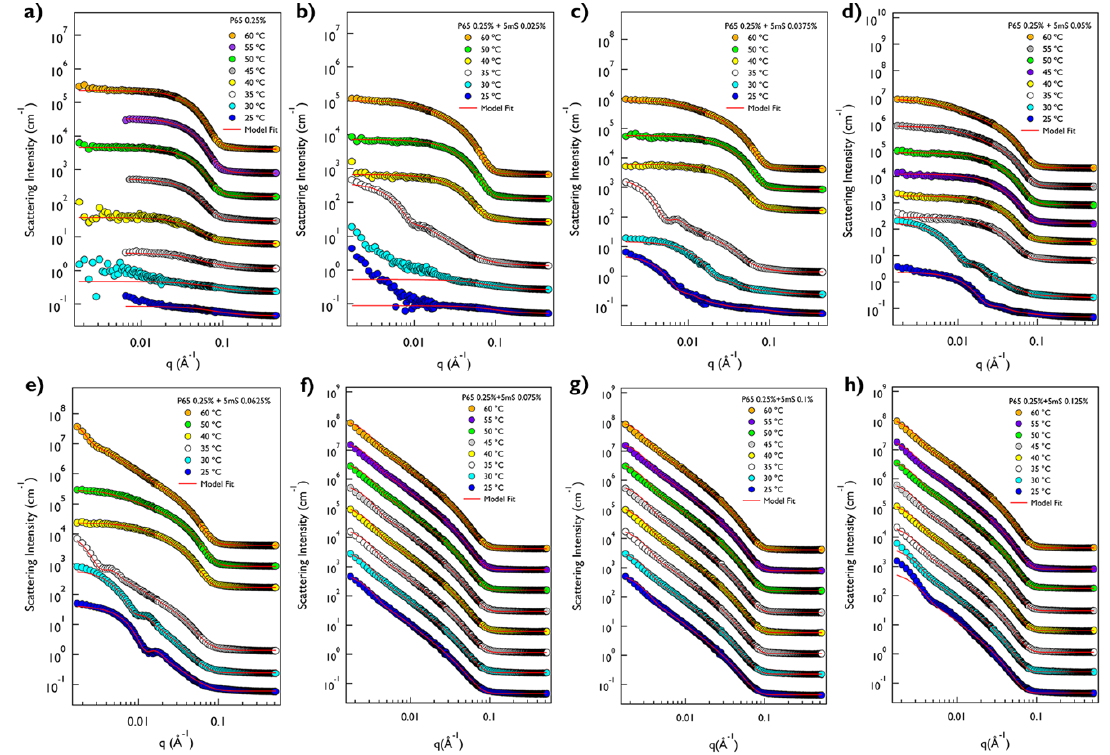
Figure 2. SANS intensities of P65-5mS mixtures in heavy water at varying 5mS concentration ( a ) 0%, ( b ) 0.025%, ( c ) 0.0375%, ( d ) 0.05%, ( e ) 0.0625%, ( f ) 0.075%, ( g ) 0.1%, and ( h ) 0.125% and temperature.